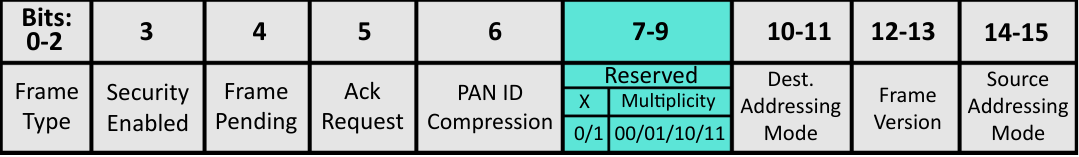
Figure 5. Detail of the dataframe MHR format, modified from the IEEE 802.15.4 standard